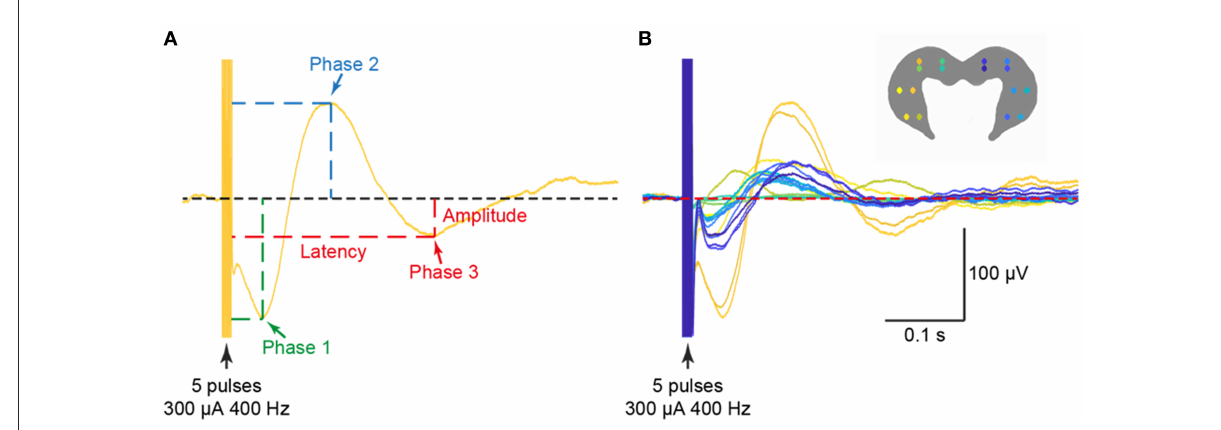
FIGURE6 Examples of triphasic waveforms (A) from all 16 electrodes (B) evoked in the ipsilateral and contralateral hippocampus from electrical stimulation of the saccule. The stimulus used was 300 µ A at 400Hz. Reproduced with permission from Hitier et al. (38).